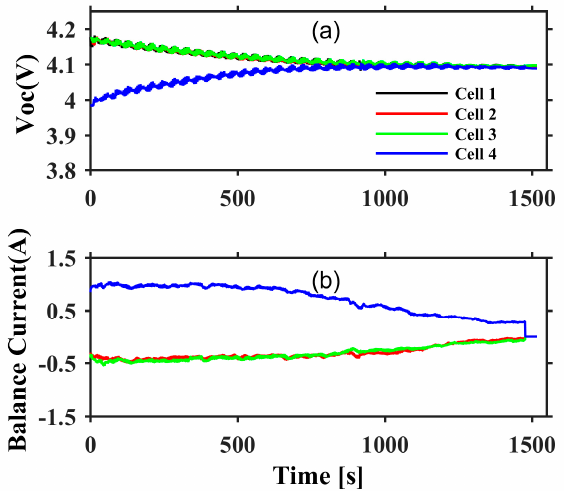
Figure 16. Experimental results for the NCA battery pack with an FL controller. ( a ) OCV for each cell; ( b ) Average balancing current for each cell.